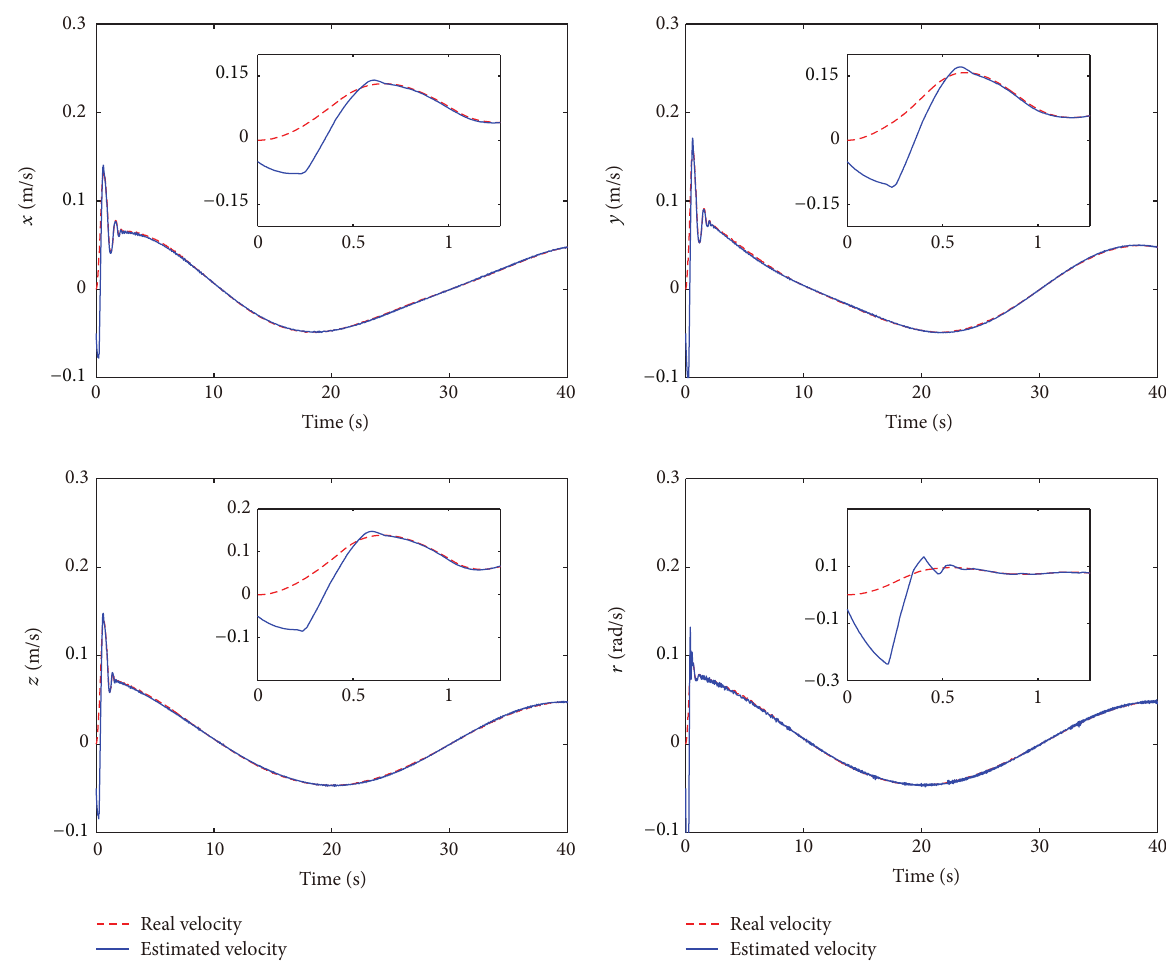
Figure 13: Estimated velocity and real velocity of output feedback IO-NTSMC with boundary